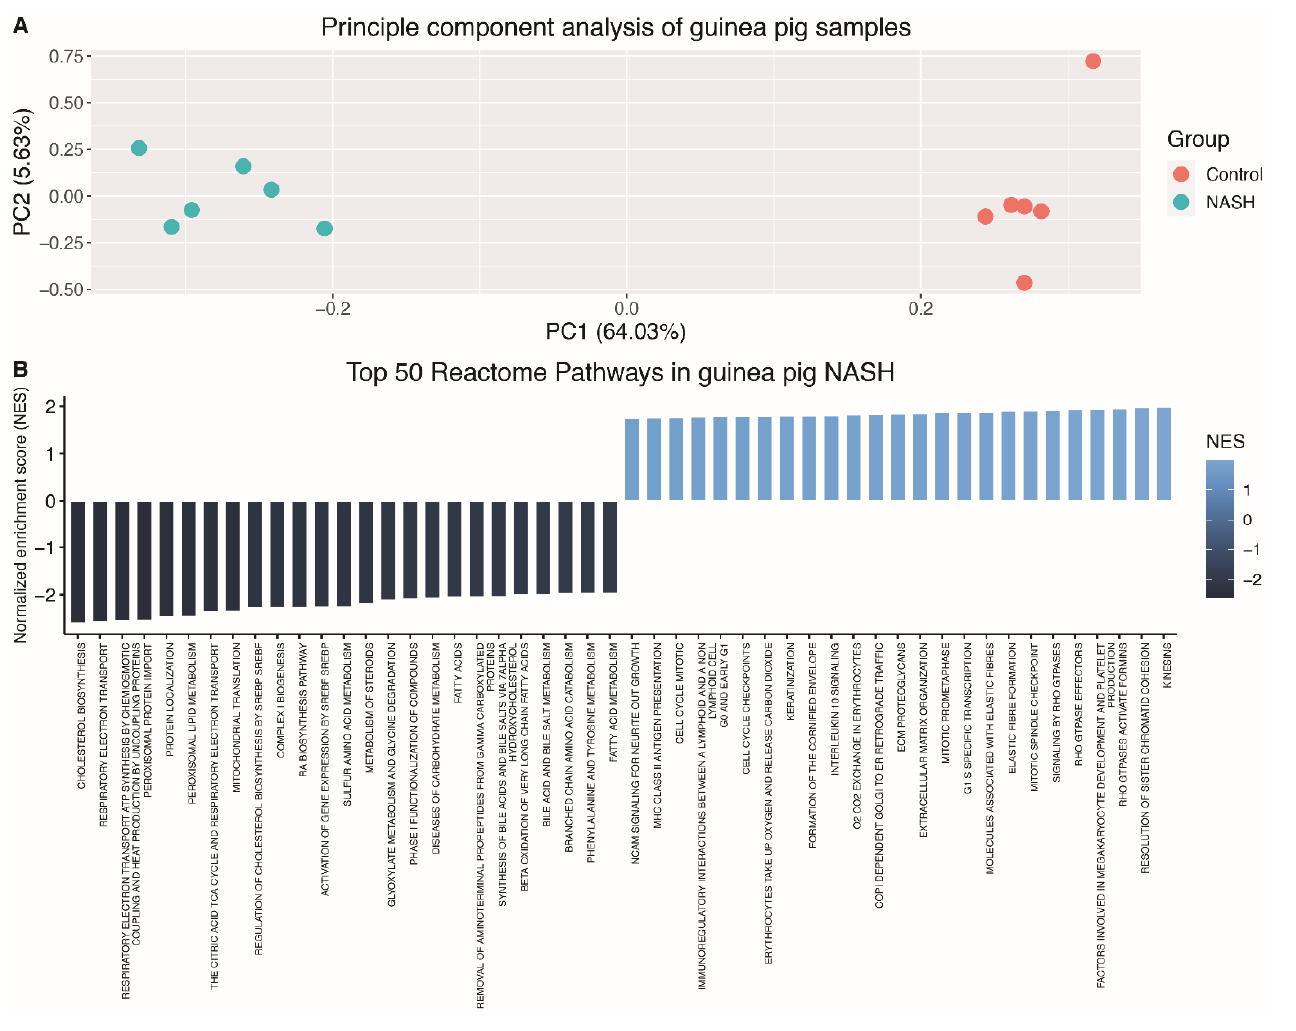
Figure 2. Principal-component analysis and top 50 dysregulated pathways in guinea pigs with NASH ( A ) Principal-component analysis plot of guinea pig samples. NASH and control animals clearly separated on the basis of all genes by PC1 explaining 64.03% of the total data variance. ( B ) Top 50 reactome pathways obtained from GSEA in guinea pigs with NASH vs. healthy controls. Top 50 pathways included the 25 most upregulated and the 25 most downregulated pathways. All pathways were selected on the basis of corrected Benjamini–Hochberg p -values and normalised enrichment score. PC: principal component, NASH: non-alcoholic steatohepatitis, NES: normalised enrichment score.